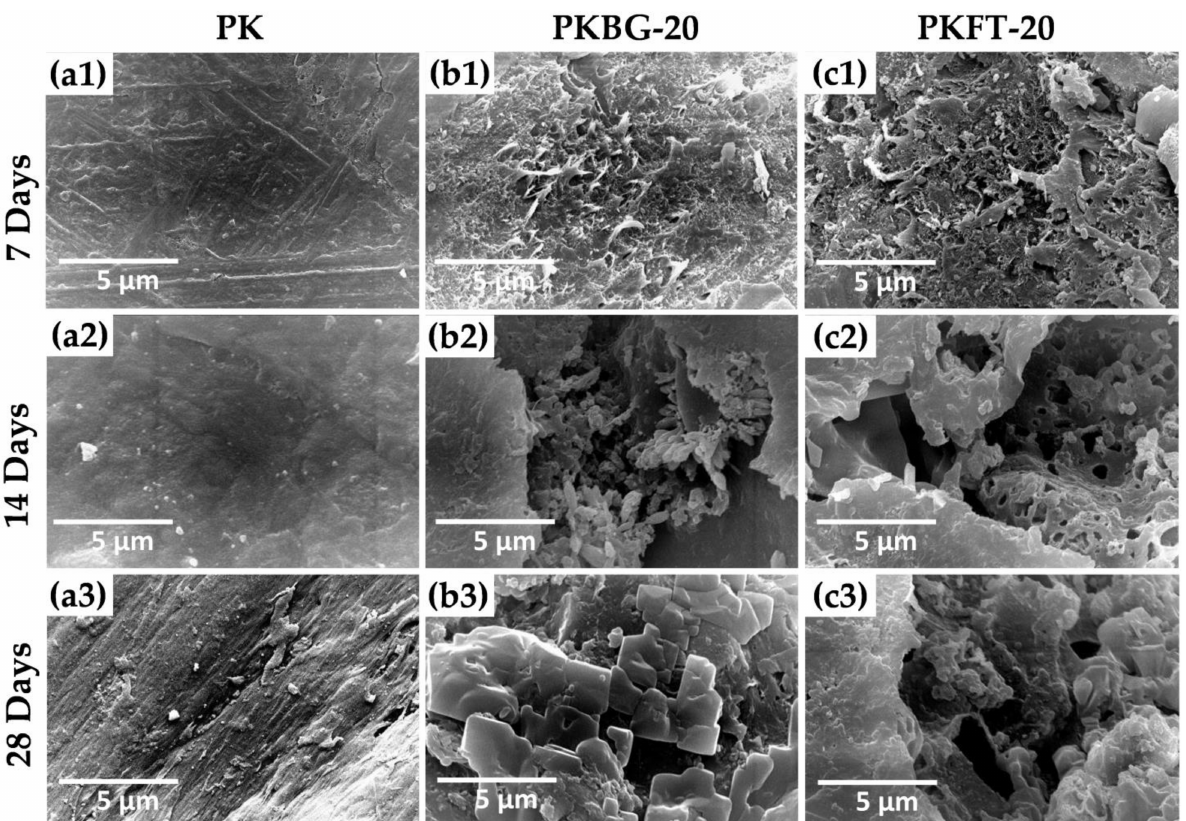
Figure 6. SEM micrographs showing the apatite-formation ability of the pure PEEK and PEEK nanocomposites after immersion in SBF for 7, 14, and 28 days: ( a1 – a3 ) pure PEEK, ( b1 – b3 ) PKBG-20 and ( c1 – c3 ) PKFT-20. No changes were observed on the surface of pure PEEK ( a1 – a3 ) but the PEEK nanocomposites ( b1 – b3 , c1–c3 ) induced apatite formation after immersion in SBF for all time